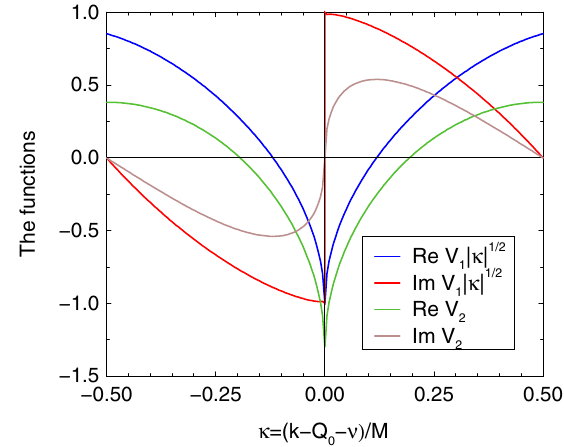
FIG. 1. Functions V 1 and V 2 characterizing the effect of re- sistive wall wakefield dependent on harmonic number. The functions period is (cid:1) (cid:13) ¼ 1 , but V 1 ð (cid:13) Þ is multiplied by factor ffiffiffiffiffiffi p j k j to suppress its singularity at (cid:13) ¼ 0 in the